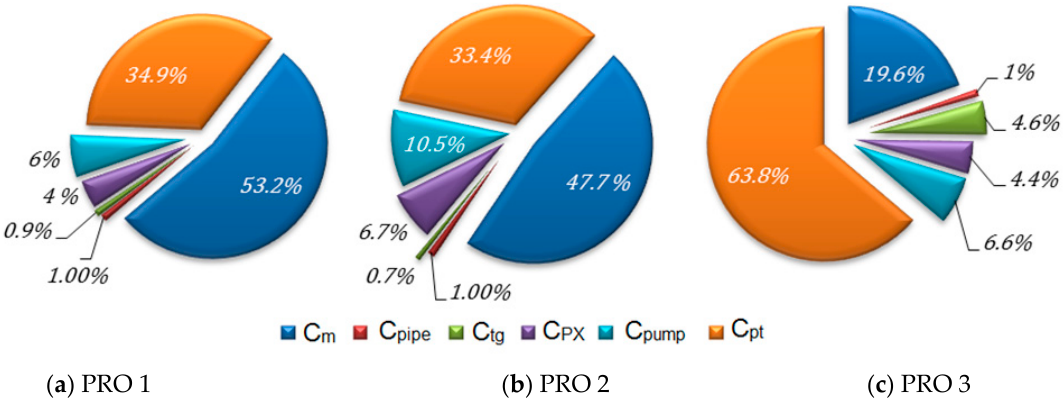
Figure 8. Typical ranges and weighted averages for the total capital costs of renewable power generation technologies (2017) [44].